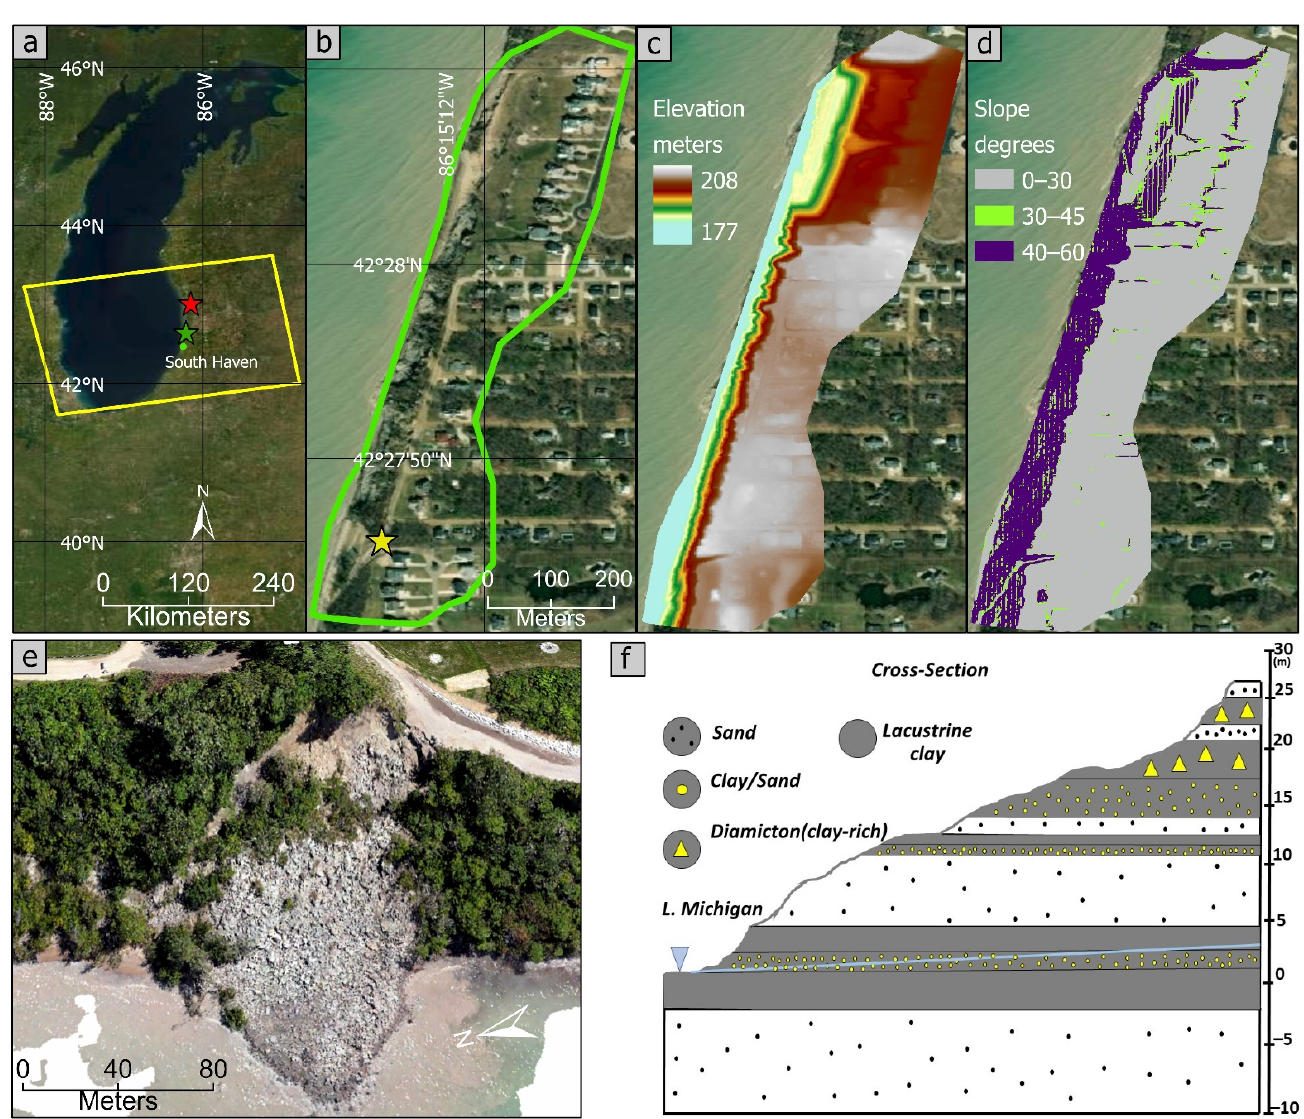
Figure 1. ( a ) Footprint of the Sentinel ‐ 1A ascending track image (track 121, frame 135; yellow polygon), the locations of the study area (Miami Park, Allegan County; green star), and the weather and tide/water level station (Holland; red star) plotted over an ArcGIS pro base map. ( b ) High ‐ resolution (0.5 m) view of the base map over the study area (Miami Park outlined by green polygon). ( c ) A digital elevation map derived from lidar digital elevation model shows the highest elevations on the top of the bluff and the lowest on the toe of the cliff. ( d ) Slope map; the bluff face is relatively steep (40°–60°) and faces west or northwest. ( e ) An orthophoto image generated from a UAV survey conducted on 10 August 2019; the figure shows a landslide within the study area and its location is shown as a green dot on Figure 1a. ( f ) A generalized schematic lithological cross-section for